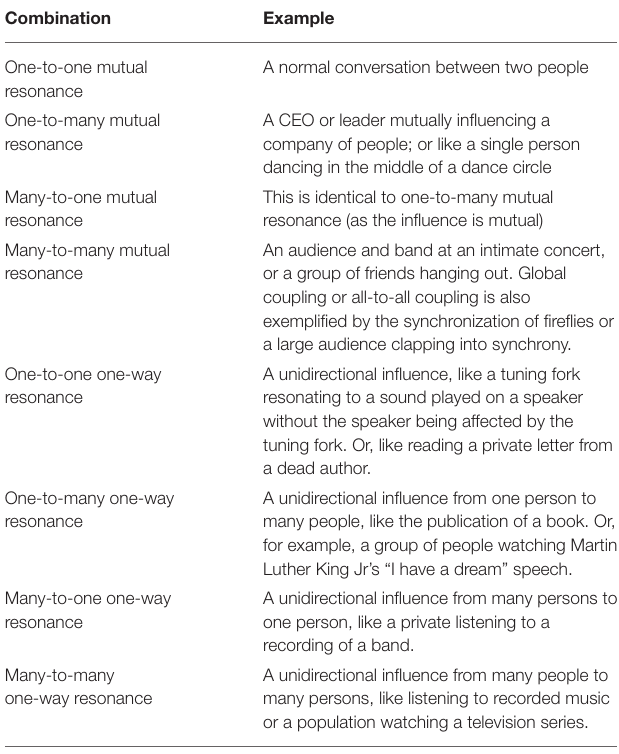
TABLE 2 | An initial design space for resonance showing the combination of plurality (number of participants) and reciprocity (mutual vs. one-way influence).